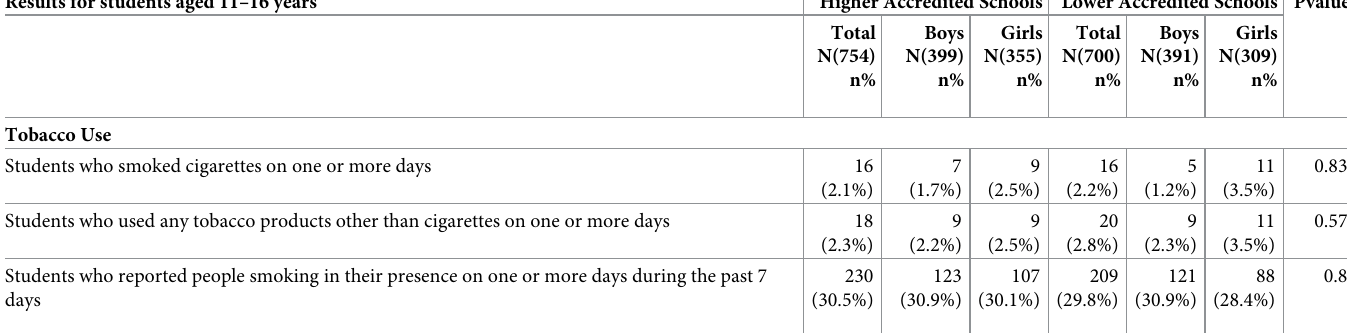
Table 5. Comparison of key behaviours of (tobacco, alcohol, drug abuse, violence) and mental health among school children in higher and lower accreditation schools in Chandigarh. Results for students aged 11–16